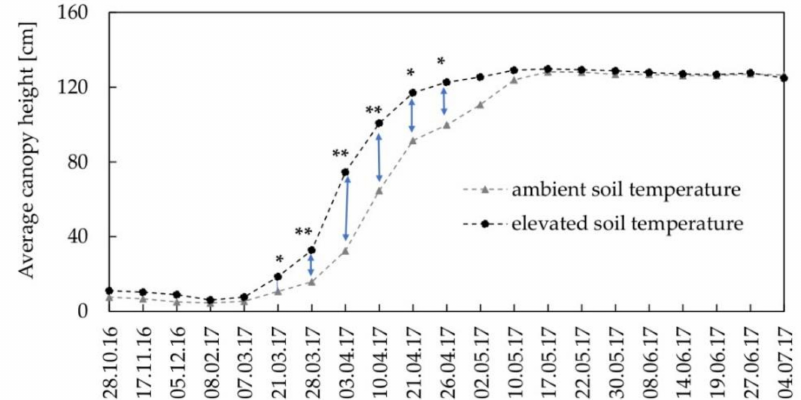
Figure 2. Canopy height measured between 28 October 2016 and 4 July 2017 at ambient and elevated soil temperature. Asterisks indicate significant di ff erences (** p ≤ 0.01, * p ≤ 0.05) between plants grown under ambient and elevated soil temperatures; n = 4. Di ff erences in average canopy height between treatments are labeled with blue arrows.